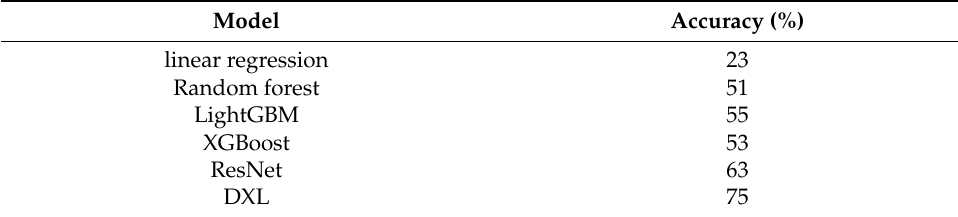
Table 4. The accuracy of the test set on other models.